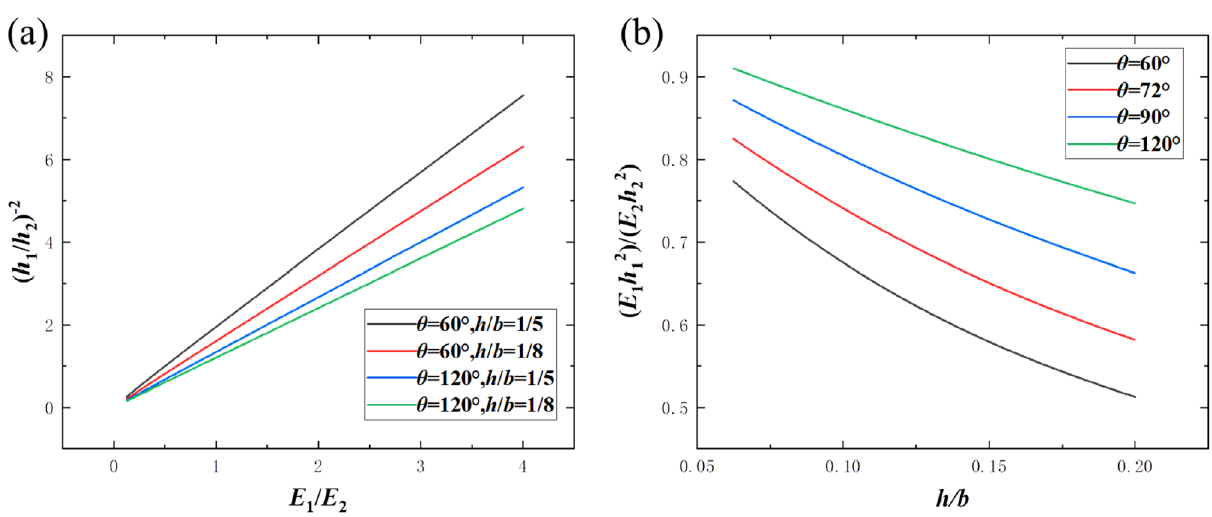
Figure 6. ( a ) Parameter relations at maximum NTE; ( b ) specific proportional coefficient curves corresponding b and θ at maximum to different h (cid:31)